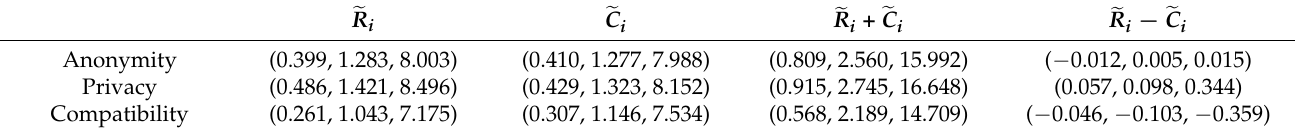
def def and ( (cid:101) R i − (cid:101) C i ) impacts using the three criteria of the social